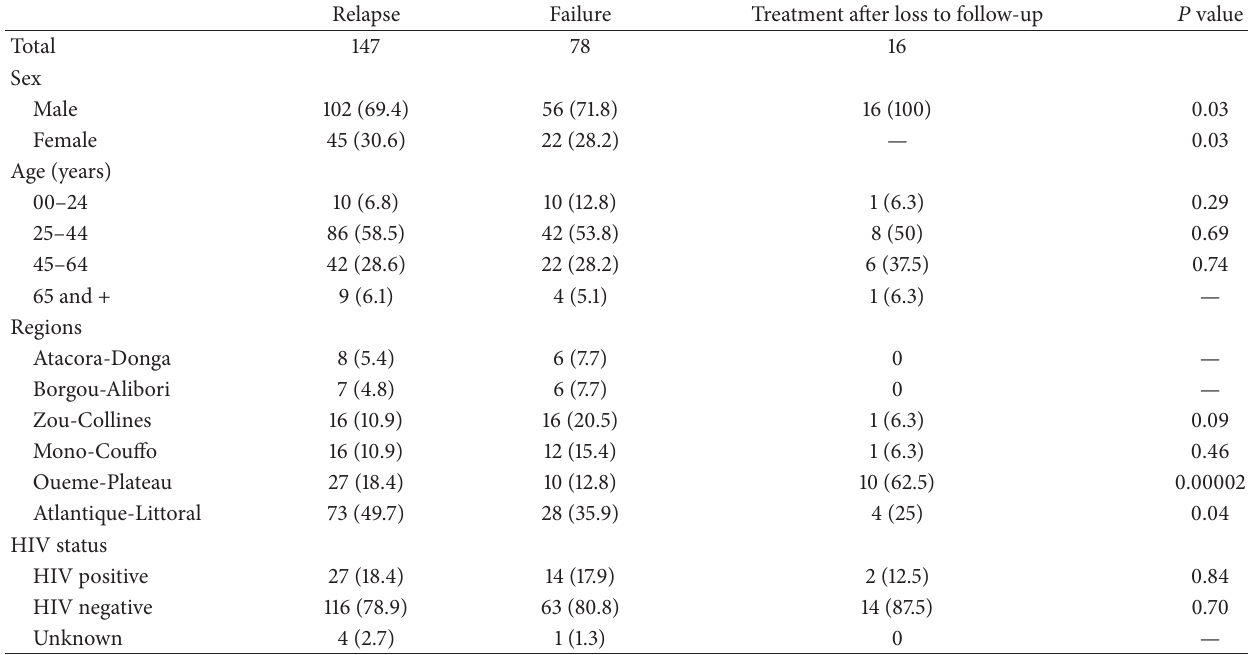
Table 3: Demographic characteristics and HIV status of the different types of retreatment tuberculosis patients, Benin, 2013.